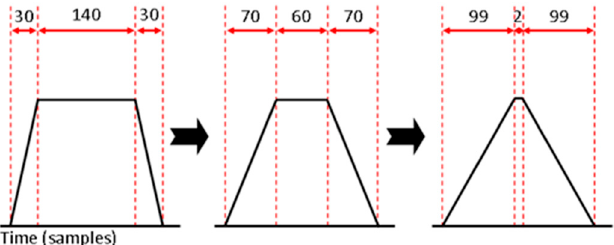
Figure 11. Visual representation of the effect of the delay values on the shape of the window, i.e., for the far-left example: delay 1, 3 = 30 samples, delay 2 = 140 samples.